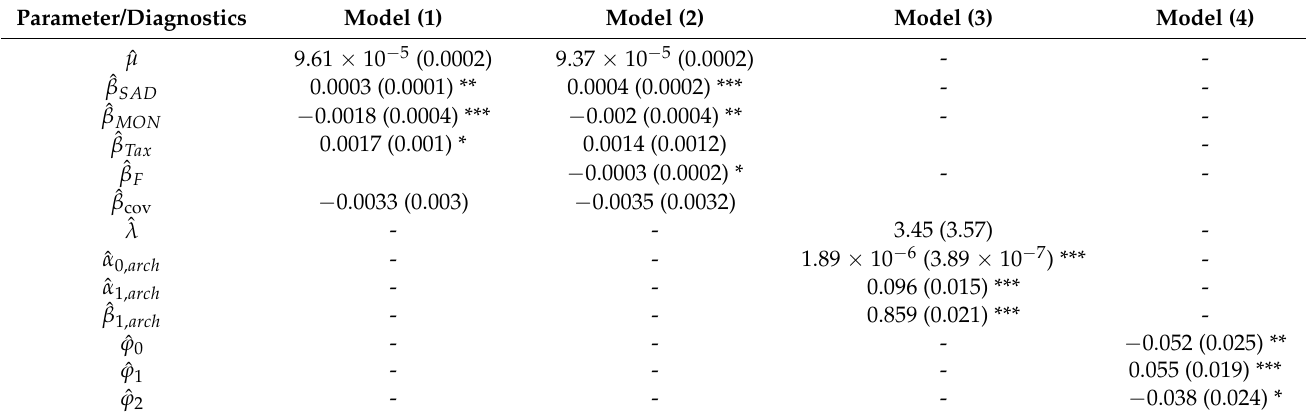
Table 3. Estimation results for the SAD and Fall effects.